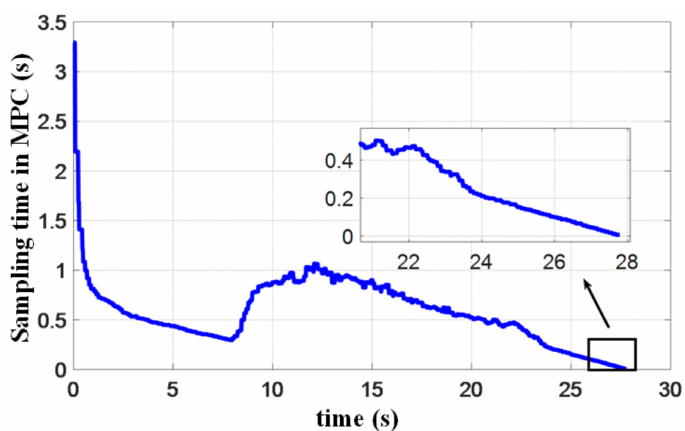
Figure 26. Sampling time of the MPC controller in the